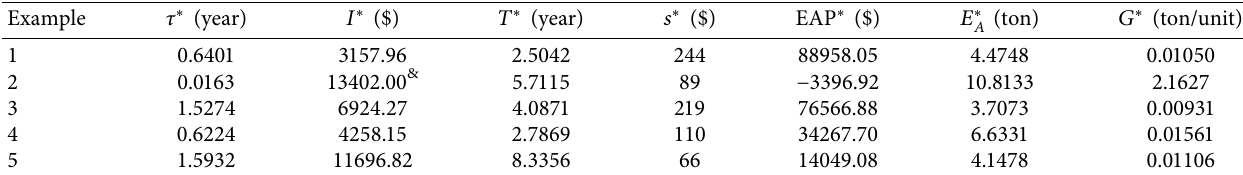
Table 3: Optimum solutions of numerical problems.